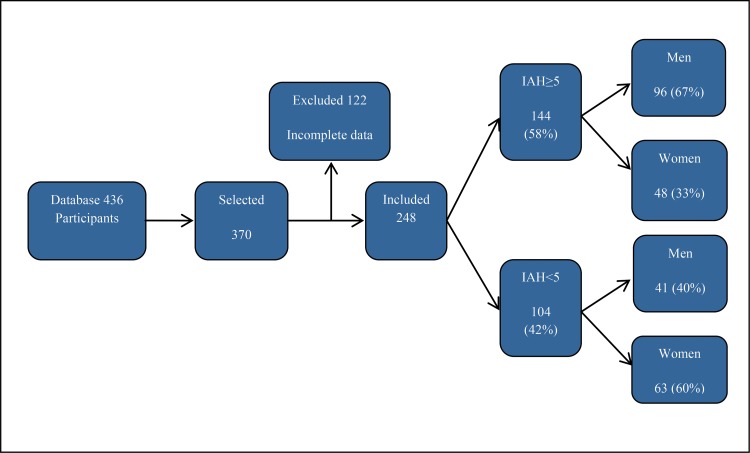
Selection criteria and sample distribution for the Apnea Hypopnea Index (AHI) and gender.